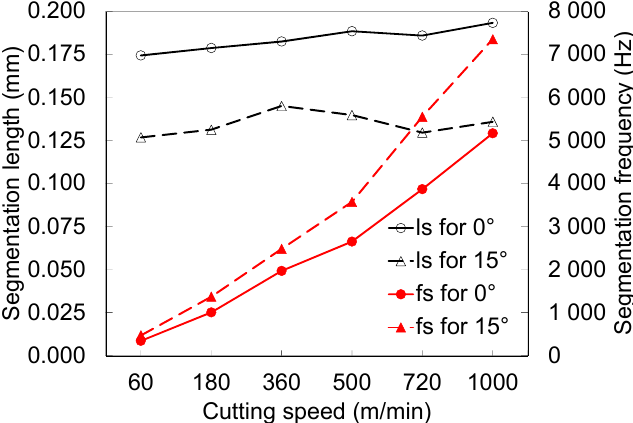
Figure 10. Segmentation length vs. segmentation frequency as function of cutting speed, for fixed feed (0.3 mm) and two rake angles (0° and 15°).